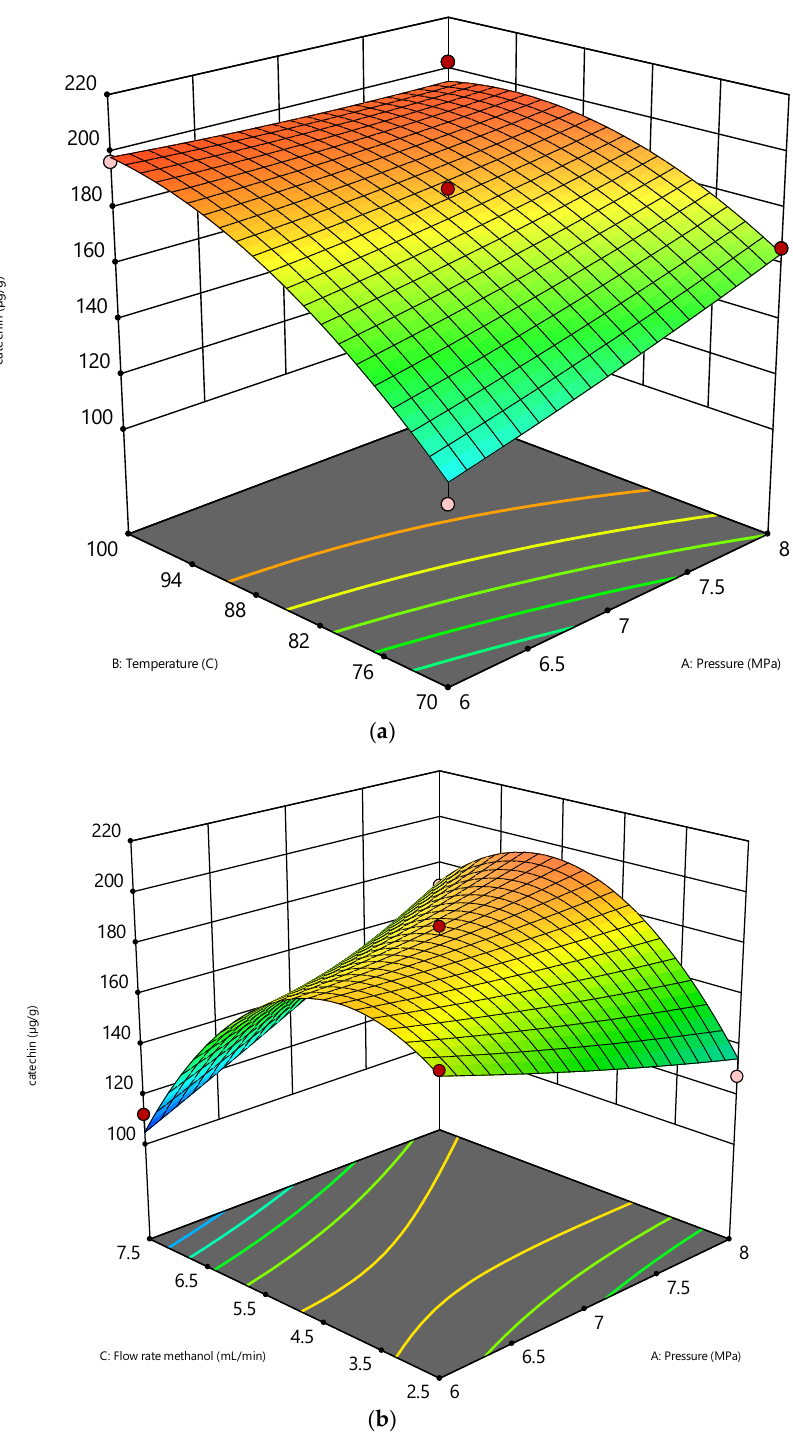
Figure 3. The effect of SME variables on catechin (µg/g): (a) effect of pressure vs temperature (b) effect of pressure vs